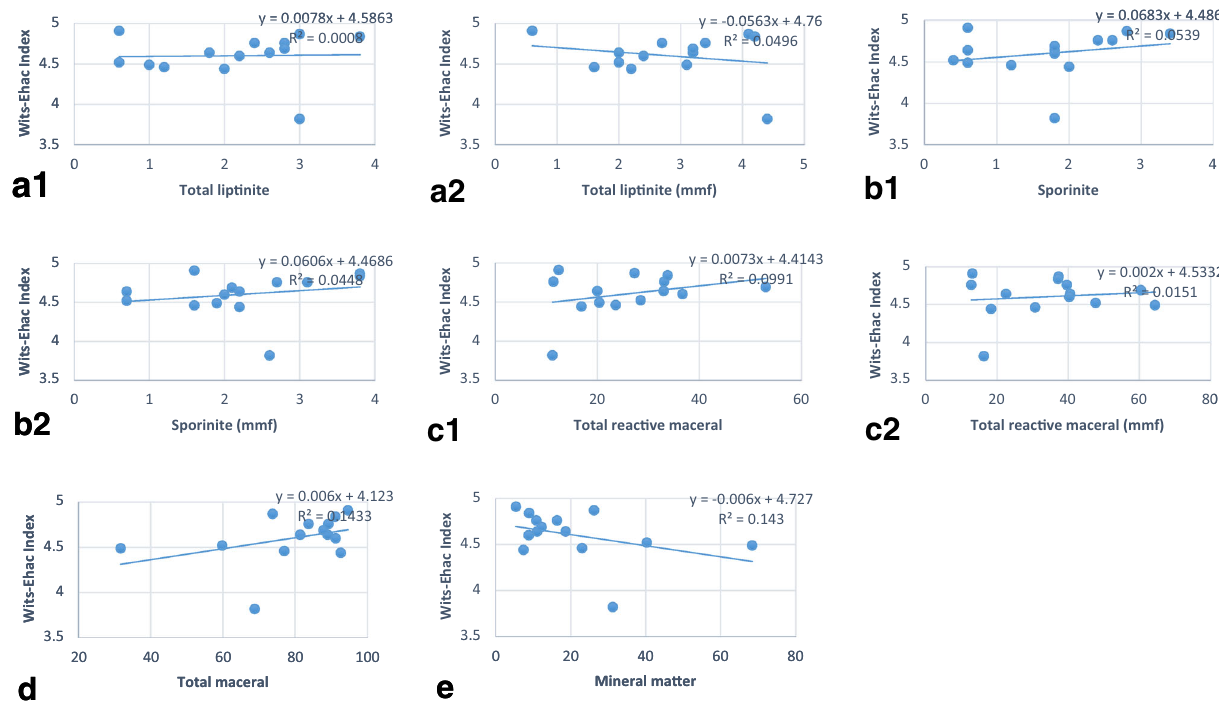
Fig. 6 Influence of total liptinite and its group, total reactive maceral, total macerals, and mineral matter on spontaneous combustion liability of